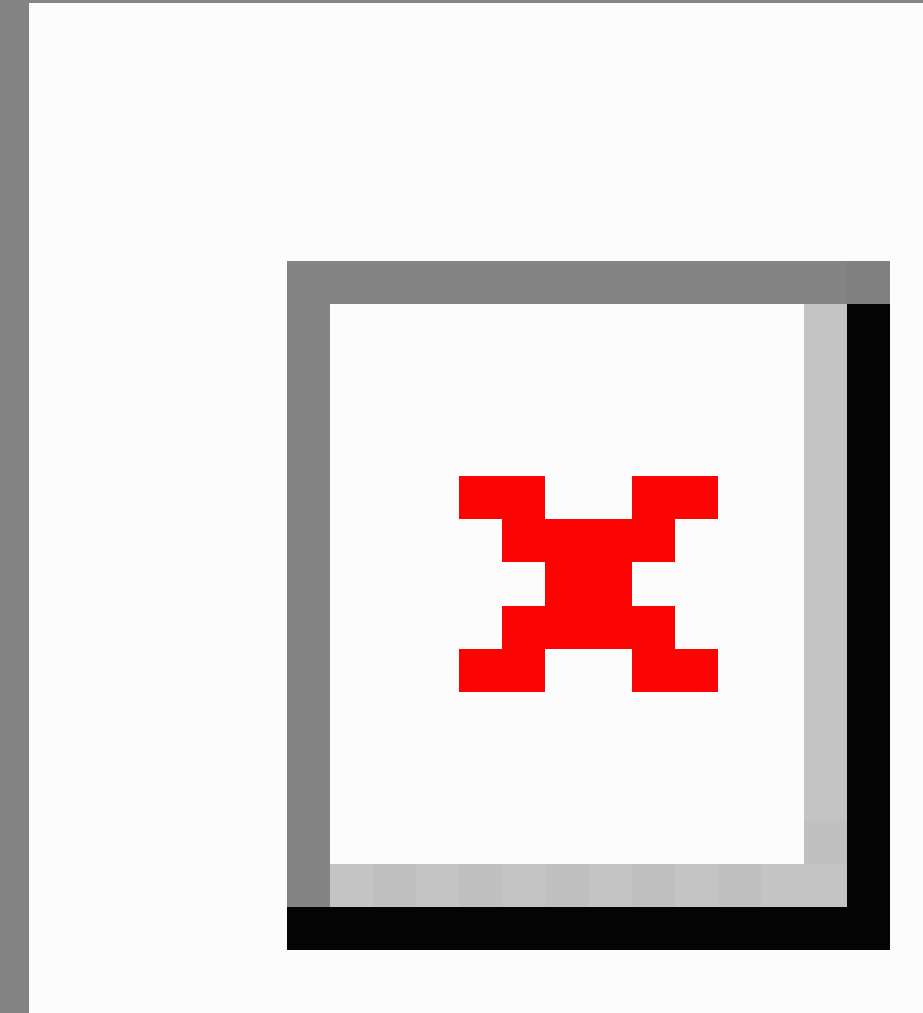
Figure 1. Zephyr